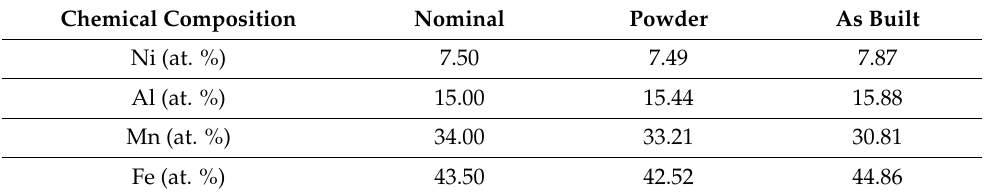
Table 1. Nominal and experimentally determined chemical compositions of Fe-Mn-Al-Ni charac- terized in form of powder and L-PBF processed bulk material. The relative standard deviation (three measurements) was found to be below